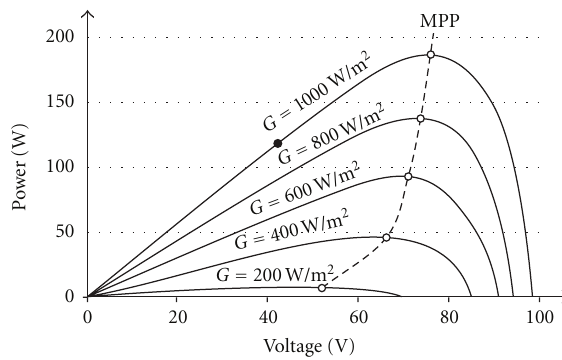
Figure 6: Power-voltage relationship in PV systems. Figure 7: Three-point weight comparison situations